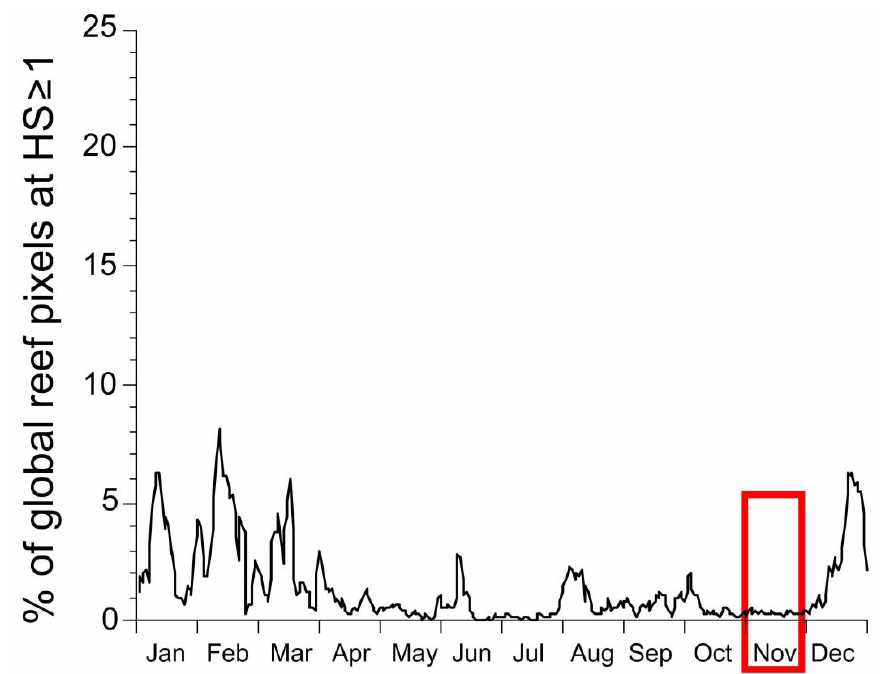
Figure 2. Percentage of global coral reef pixels at HotSpot (HS) ≥ 1 for 2002. Note that the red box represents the transition period from OSTIA reanalysis to the Geo-Polar sea surface temperature (SST) reanalysis, which took place from 1 to 28 November 2002.